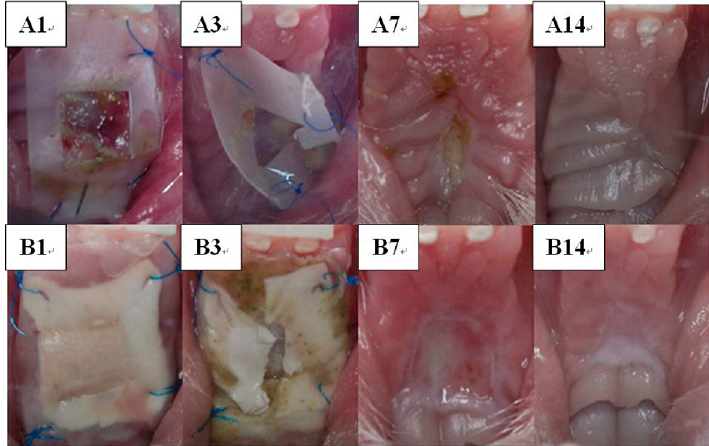
Figure 7. Wound healing in ( A ) control group and ( B ) test (nanofibrous composite membrane) group on Days 1, 3, 7 and 14 post-surgery.